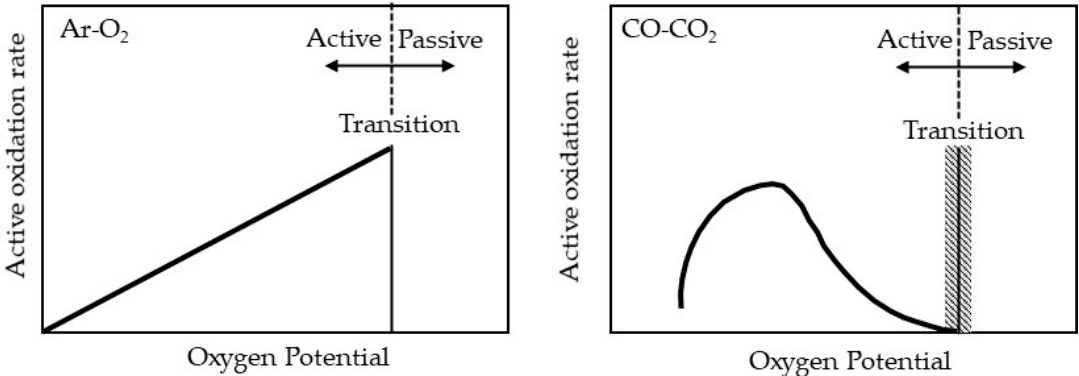
Figure 2. Schematic diagram showing the differences of oxidation rate and active-to-passive transition of SiC oxidation in active regime in Ar-O 2 and CO-CO 2 atmospheres [40].